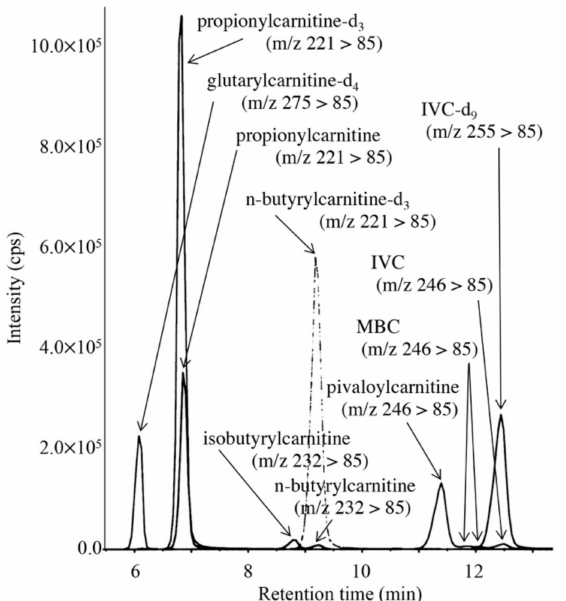
Figure 6. LC-MS/MS analysis for pivaloylcarnitine, 2-methylbutyrylcarnitine, isovalerylcarnitine, n-butyrylcarnitine, and isobutyrylcarnitine. The gradient elution program was as follows: 10% B (1 min), 10% to 40% B (4 min), 40% to 70% B (8 min), 70% to 100% B (0.1 min), 100% B (6.9 min), and 100% to 10% B (0.1